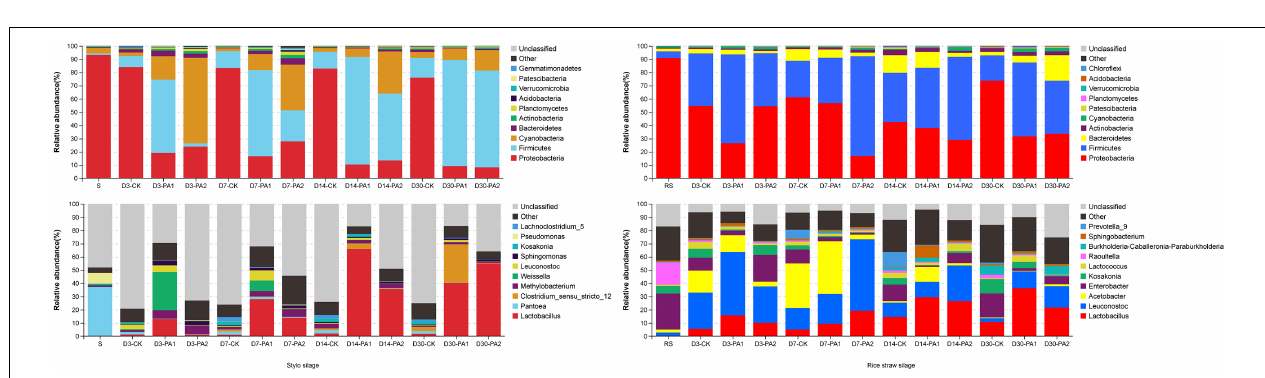
FIGURE 1 | Principal coordinate analysis of bacterial communities in stylo and rice straw before and after ensiling for 3, 7, 14, and 30 days with or without 1% or 2% pyroligneous acid.